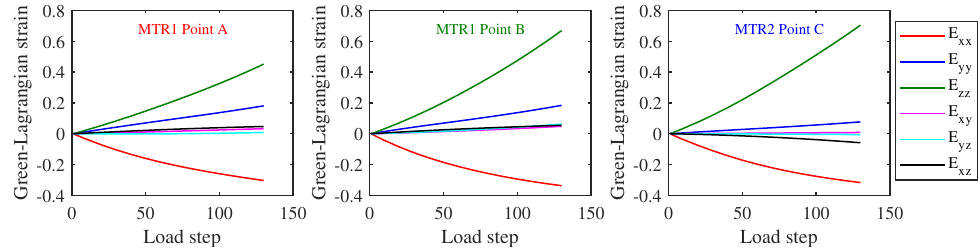
Figure 5. Green–Lagrange strain history of selected mesoscale MTR points in the 45 ◦ compression simulation. Point positions are extracted from Figure